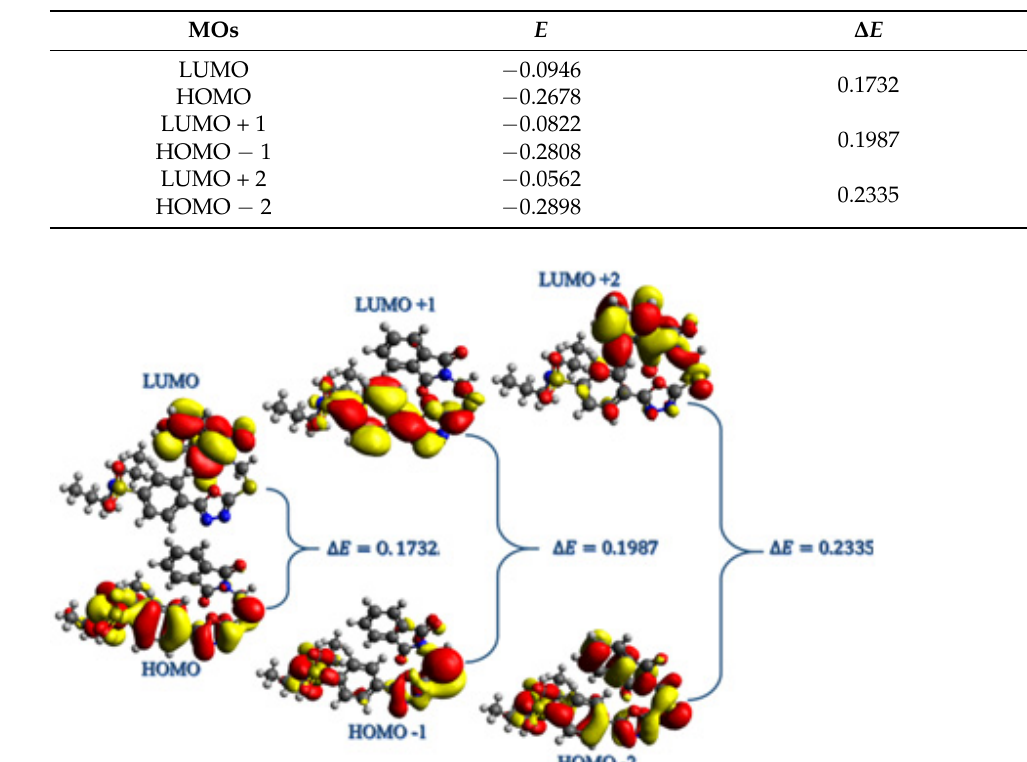
Table 4. The E HOMO , E LUMO , and ∆ E of PESMP are in a.u.